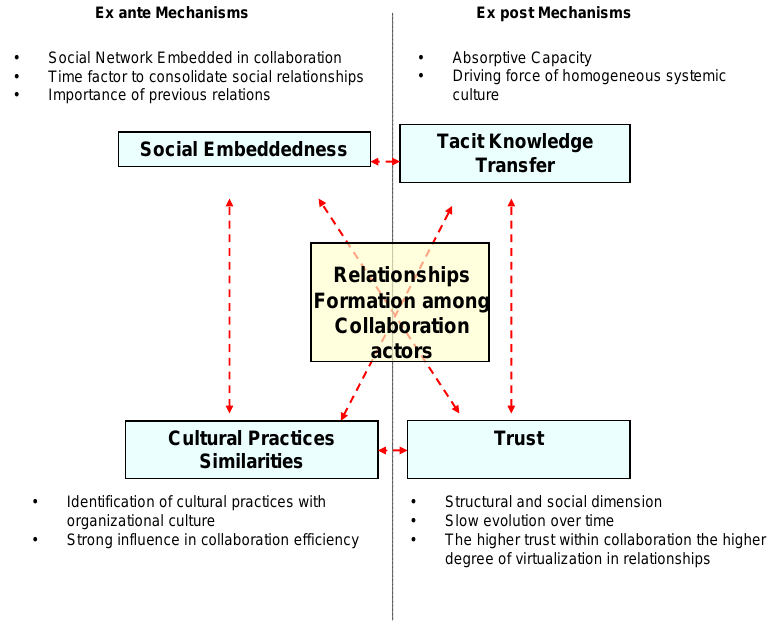
Figure 5. “Cultural mechanisms in horizontal inter-firm